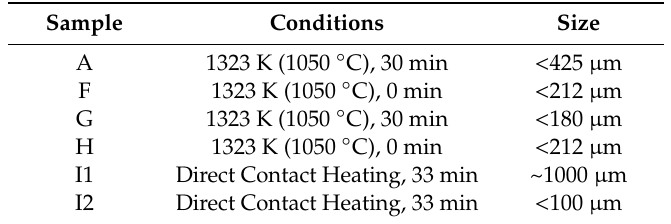
Table 4. Table 4. The γ -spodumene content and lithium extraction efficiency value for several heat-treated concentrates.